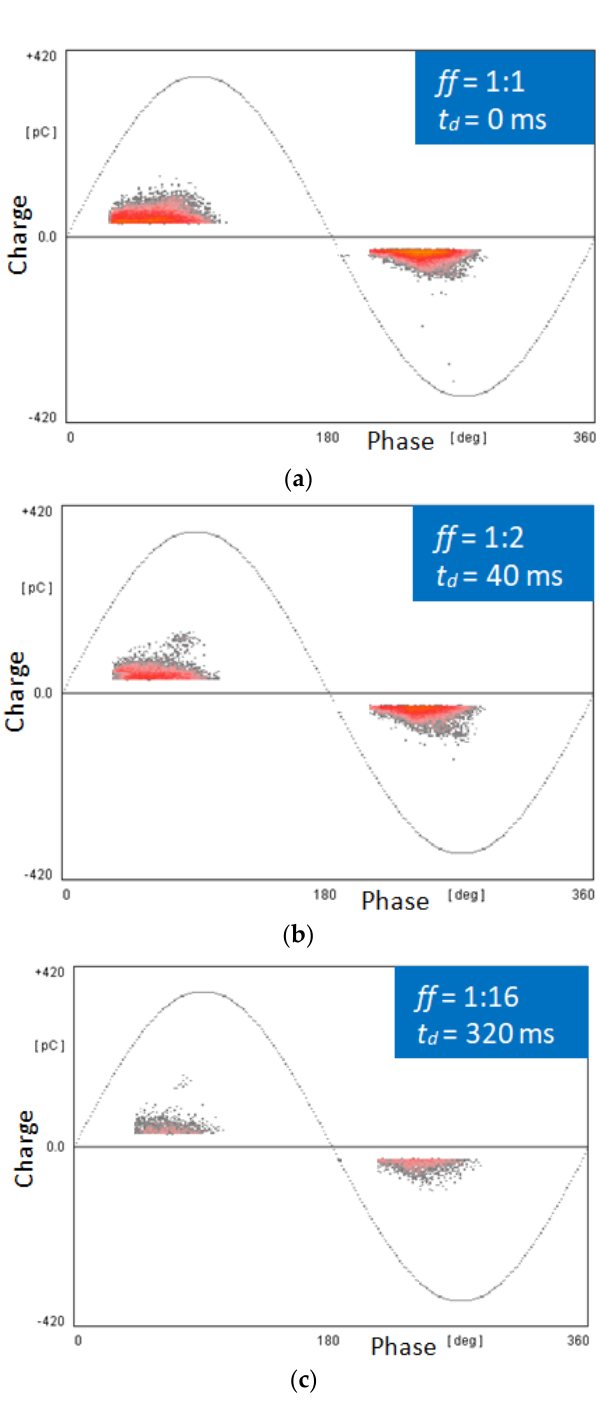
Figure 4. Partial discharges (PD) pattern obtained at ( a ) continuous sinusoidal voltage ( t d = 0 ms), at 7.5 kV, in void embedded in glass, and in a chopped PD sequence ( b ) 1:2, ( t d = 40 ms), ( c ) 1:16 ( t d = 320 ms).